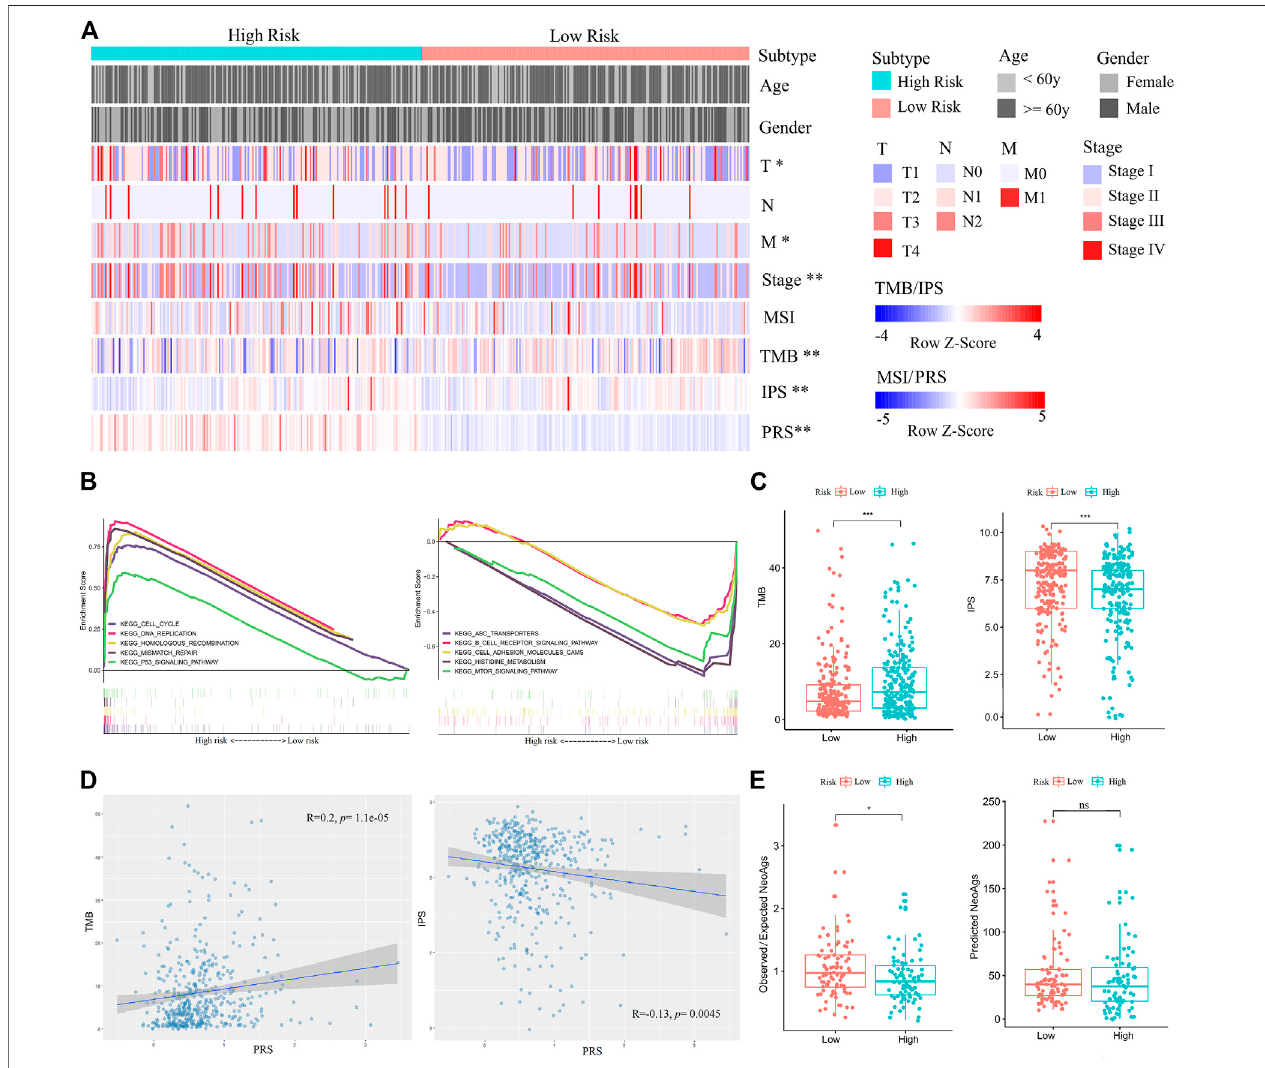
FIGURE 5 | Comparisons of clinical, immune, and molecular features between high- and low-risk patients in the training set. (A) Associations of three immunophenotypeswith10variables.Fisher ’ sexacttestwasusedforcategoricalvariables:age,sex,pathologicalstage,tumorsize(T),lymphnodemetastasis(N),and distantmetastasis(M).Wilcoxontestwasusedforcontinuousvariables:MSI,TMB,IPS,andPRS. (B) GSEA(C2:curatedgenesets,CP:KEGG)showedthatthe fi vetop pathways upregulated in the high-risk group were cell cycle, DNA replication, homologous recombination, mismatch repair, and p53 signal pathway (left). The fi ve top pathways upregulated in the low-risk group were ABC transporters, B cell receptor signaling pathway, cell adhesion molecules (CAMs), histidine metabolism, and mTOR signaling pathway (right). (C) Comparisons of TMBs and IPSs between high- and low-risk patients. (D) The positive correlation between TMB and PRS is shown ontheleft.ThenegativecorrelationbetweenIPSandPRSisshownontheright. (E) ComparisonsofObserved/ExpectedNeoAgsandPredictedNeoAgsbetweenhigh- and low-risk patients. The symbol “ ns ” represents there is no signi fi cant difference between the two groups.